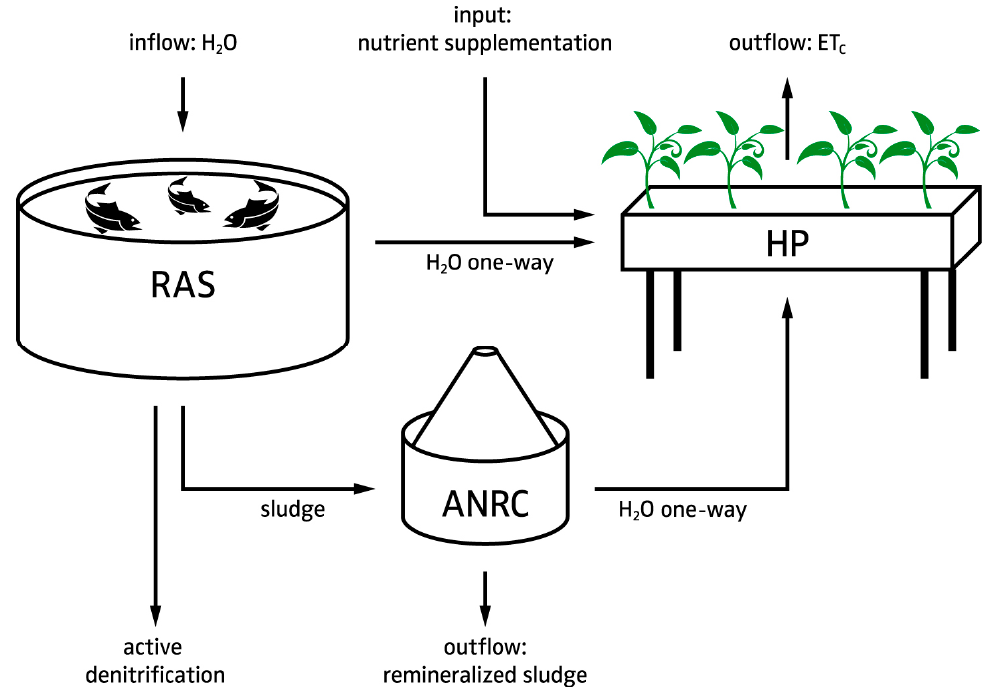
Figure 6. Water flow in a DAPS. As the ANRC is expected to remove most of the N, active denitrification might be needed in the RAS to reduce the nitrate concentration. This is especially the case if the water flow to the hydroponic component is not sufficient to keep the RAS water quality at a desired level. The flow chart also shows other amendments to the one-loop aquaponic system approach: (1) an ANRC that remineralizes the sludge and reduces water and fertilizer requirements; and (2) manual nutrient supplementation and nutritious ANRC nutrient outflows provide the hydroponic component with optimal nutrient concentrations that do not dilute in the whole system.